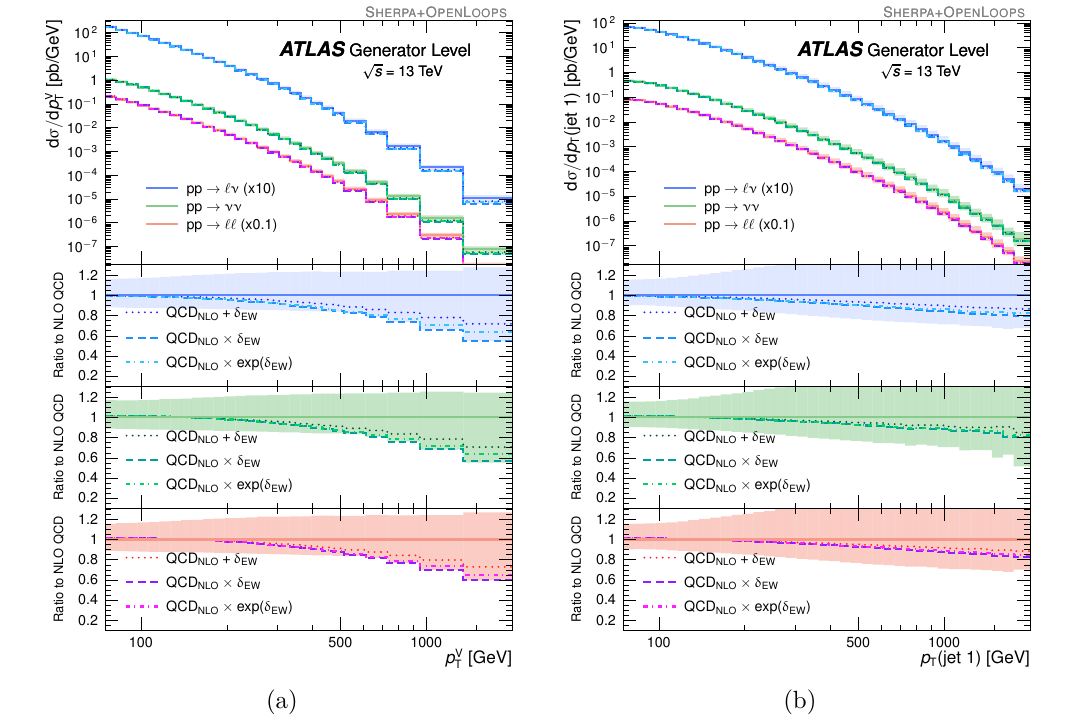
Figure 1 . Differential distributions of the transverse momentum of (a) the boson and (b) the highest transverse momentum jet for pp → ‘‘, νν, ‘ν processes. The QCD accuracy of all predictions is 0–2j@NLO+3–5j@LO. The electroweak virtual corrections are denoted by ∆ ‘ν final states have been averaged from electron, muon and τ -lepton final states. The shaded bands include scale uncertainties calculated from the envelope of renormalization and factorization